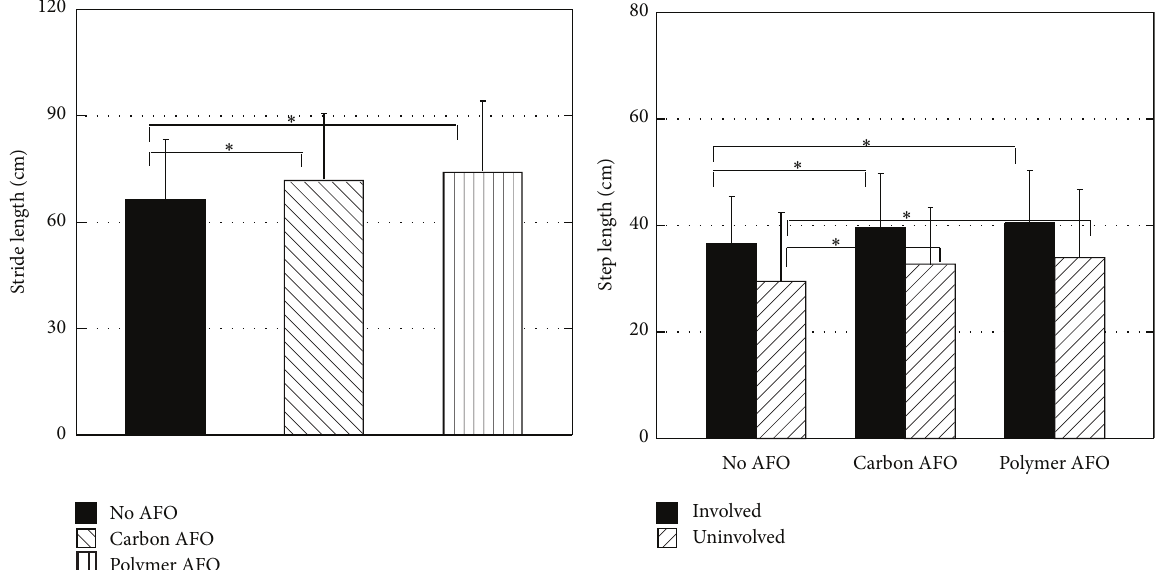
Figure 3: Stride length and step length recorded during walking without an AFO and with a carbon AFO or plastic AFO. ∗ shows statistical significance ( 𝑃 < 0.001